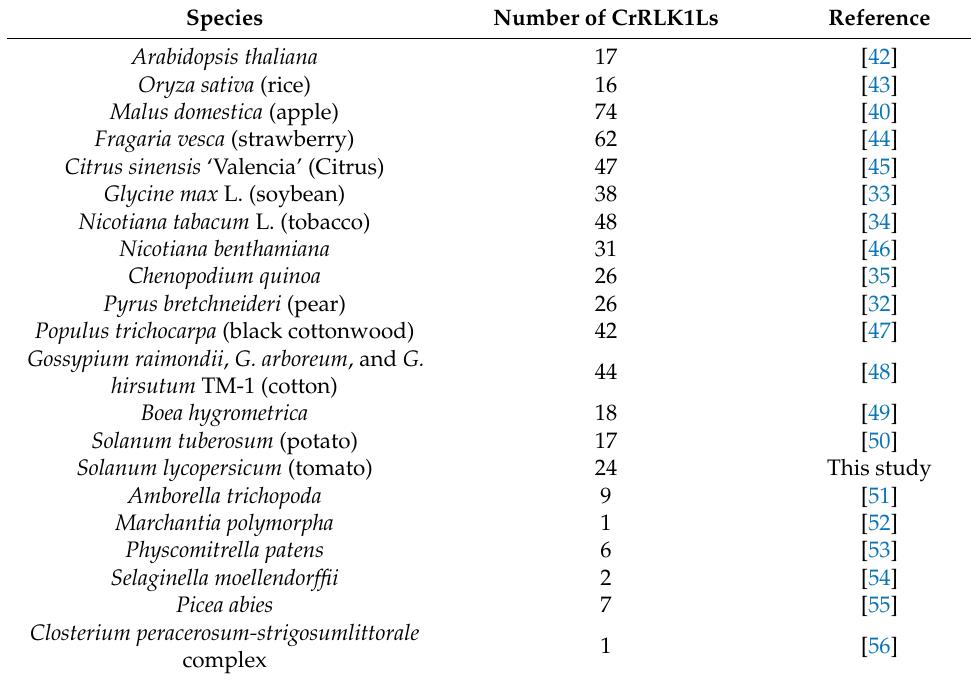
Table 2. The identified CrRLK1L numbers in various